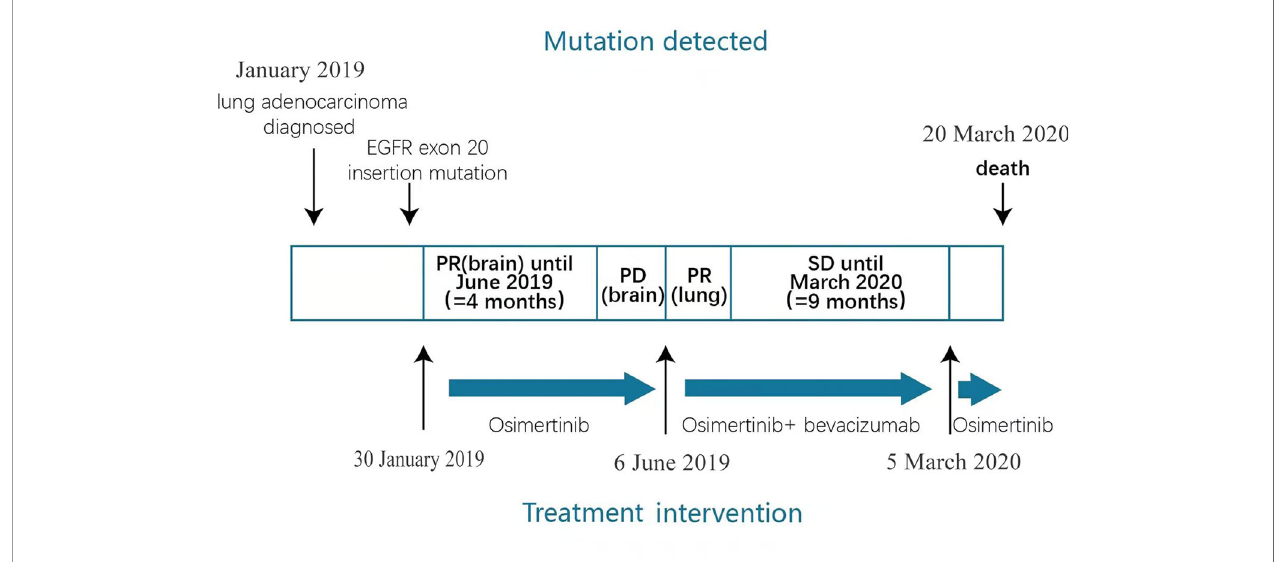
FIGURE 3 | Patient clinical course including treatment process and relevant